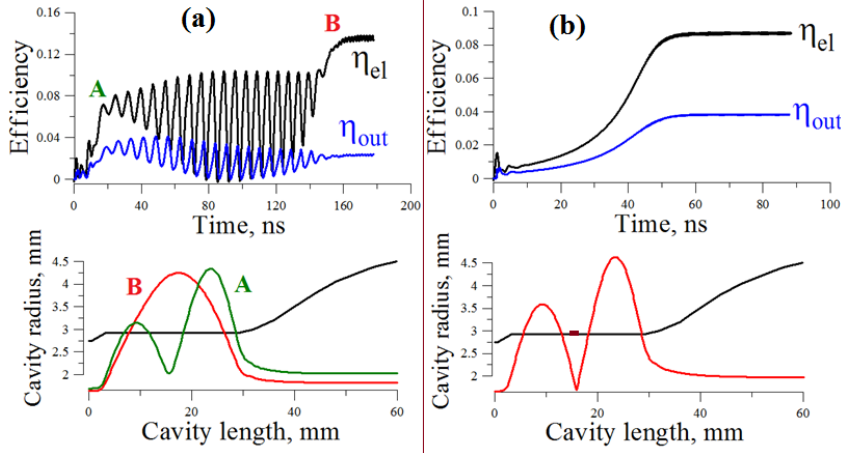
Fig. 4. Dynamics of excitation of the gyrotron during the transition to operation in the TWT mode for the case of a regular (a) cavity and a cavity with an absorber